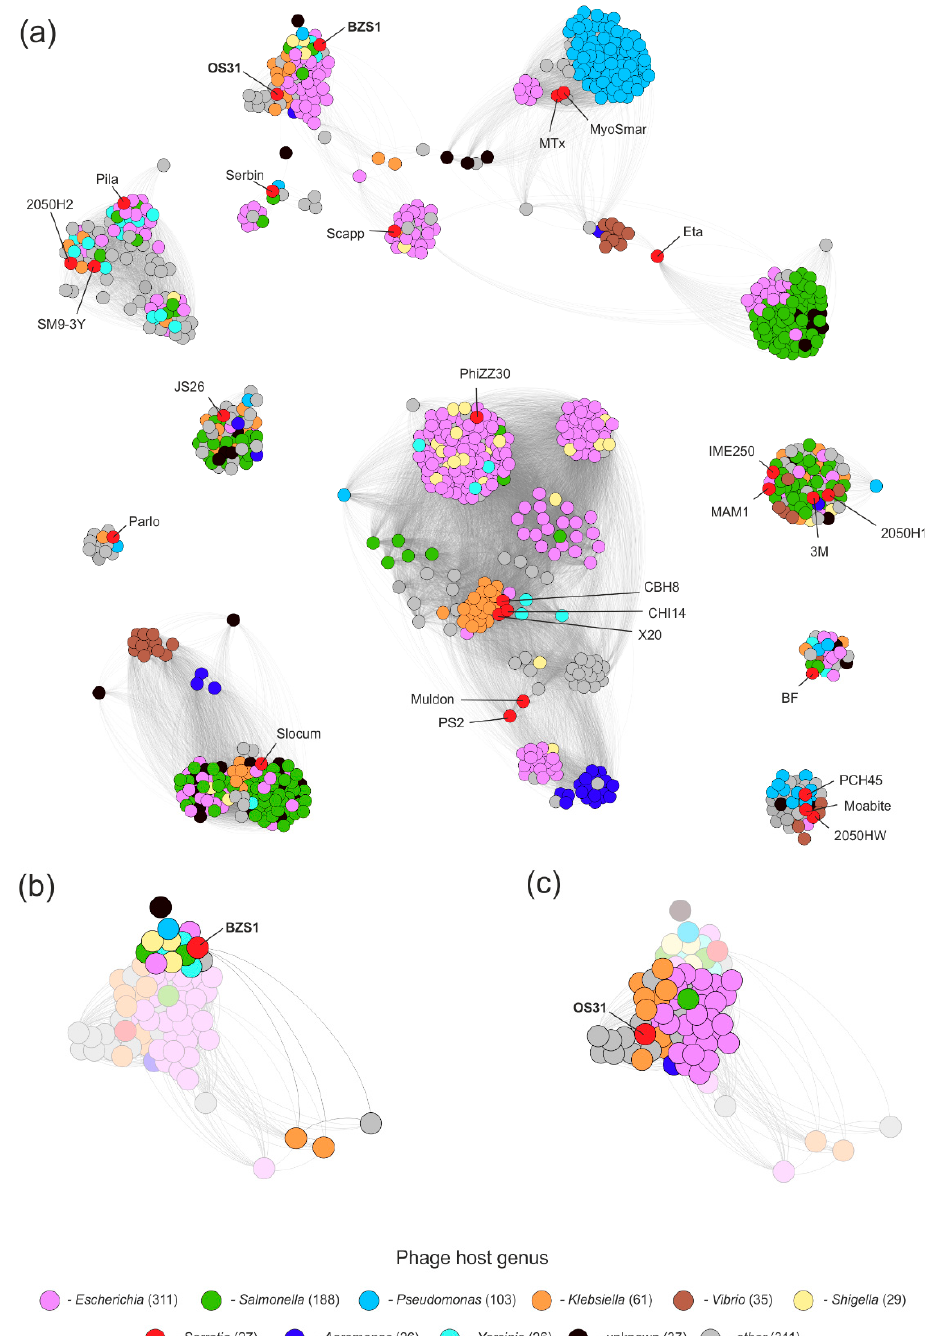
Figure 4. Protein-based phage similarity network. Phage genomes from NCBI were compared with BZS1 and OS31 phages with the application of vConTACT v0.93. On the network, only phages exhibiting similarity to Serratia phages were considered to yield a network of 1039 nodes – panel ( a ). In particular, phages showing similarity to BZS1 and OS31 phages were highlighted on panel ( b , c ), respectively. Node colors were used to indicate phage hosts according to the